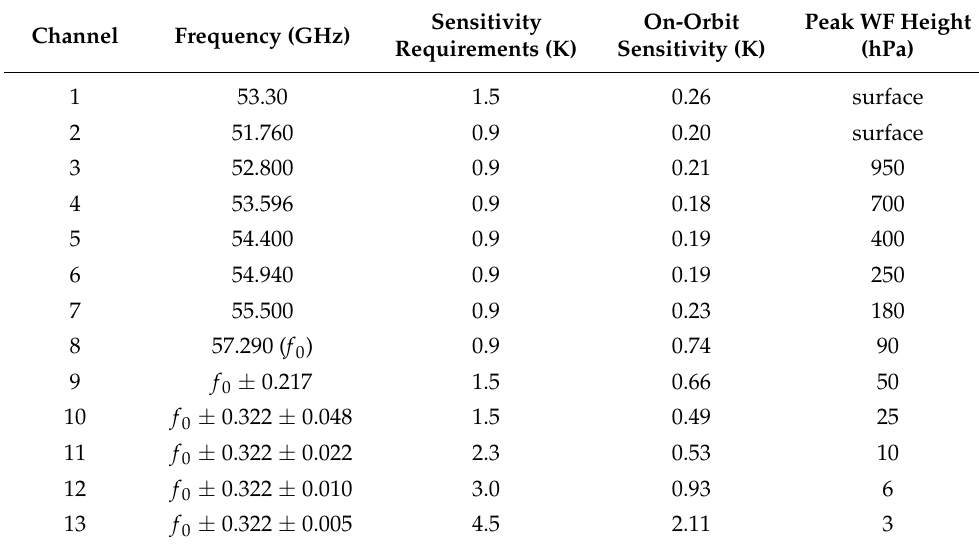
Table 1. Channel characteristics of